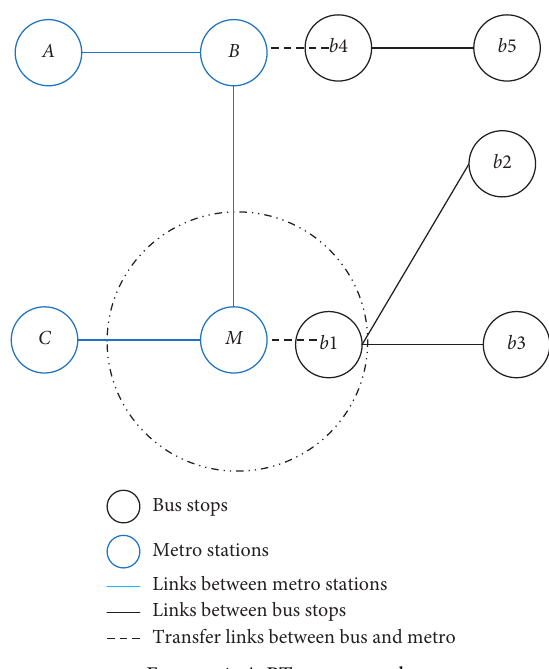
Figure 4: A PT toy network.